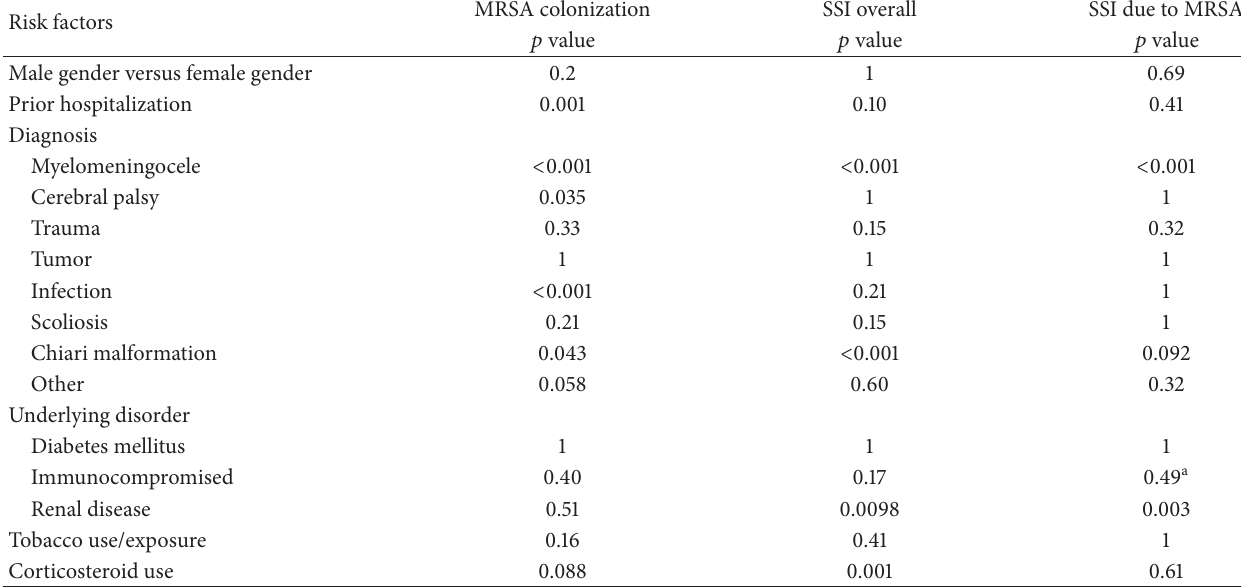
Table 2: Univariate analysis of risk factors for MRSA colonization, SSI overall, and SSI due to MRSA. Risk